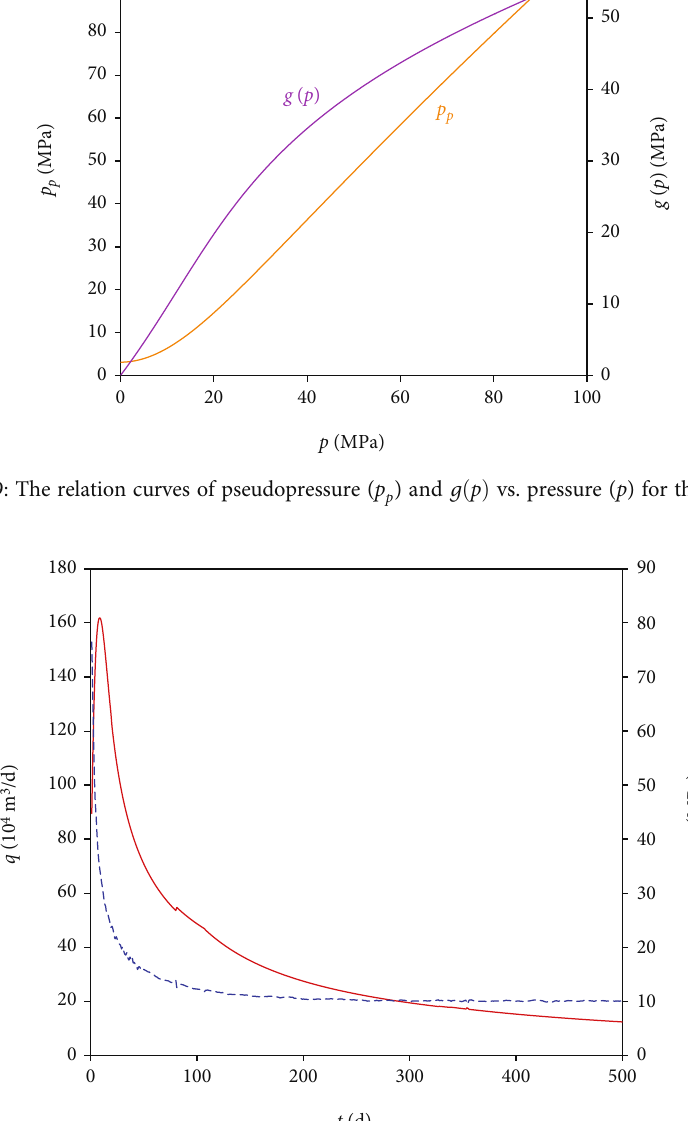
Figure 20: Production history of the gas well